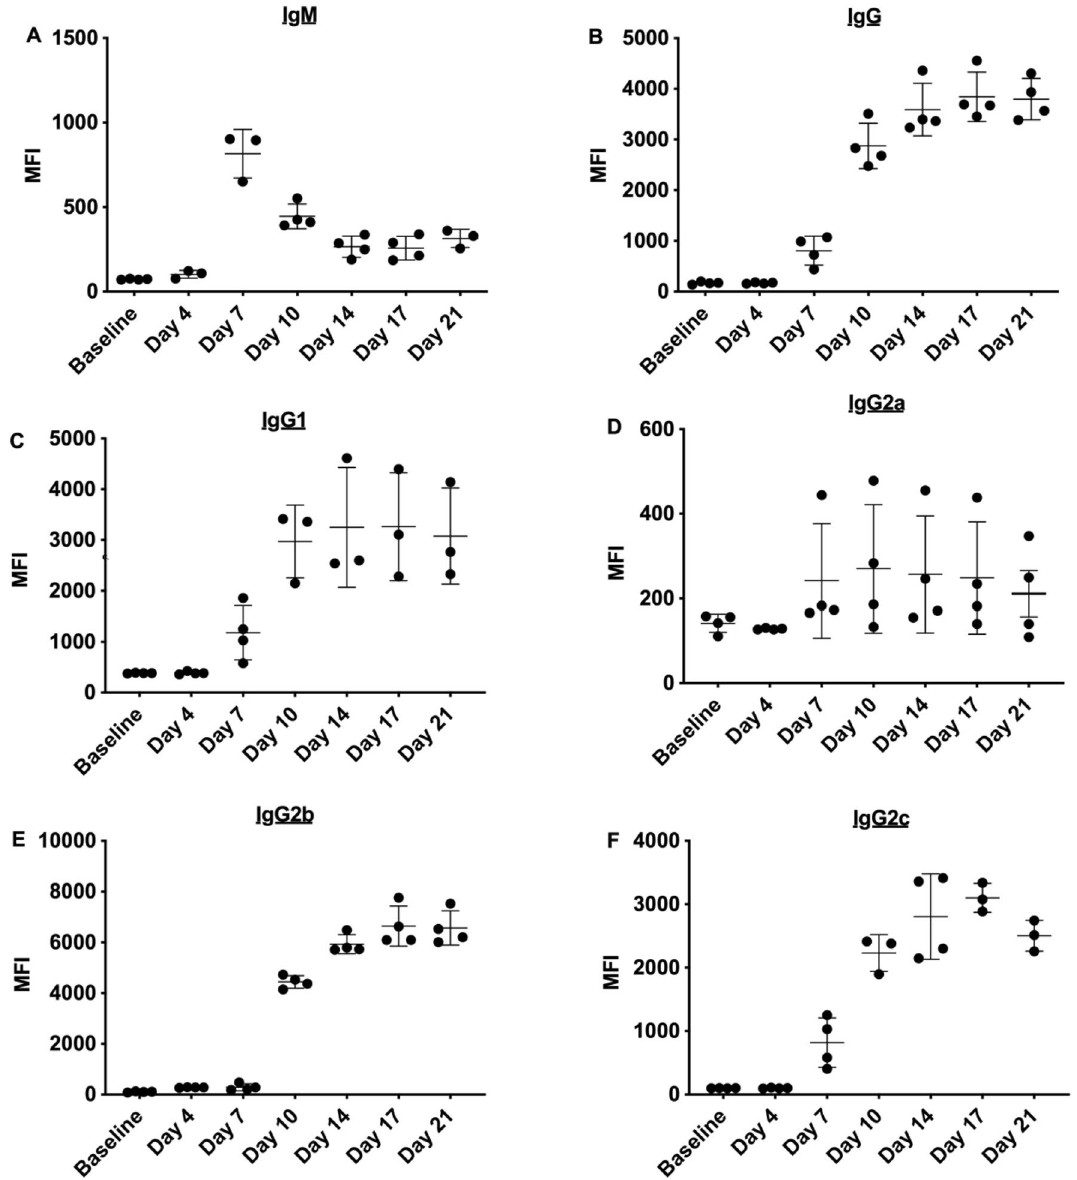
Figure 1. Whole F344 blood transfusion to LEW rats induces an alloantibody response. Flow cytometry T lymphocyte crossmatch was performed to detect allogenic ( A ) IgM levels, ( B ) IgG levels and IgG subsets ( C ) in sensitized LEW rats (n =